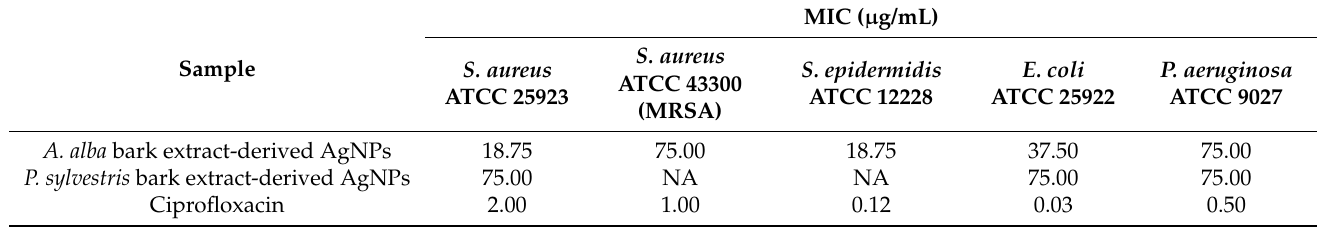
Table 2. Antibacterial activity of Abies alba and Pinus sylvestris bark extract-derived AgNPs.